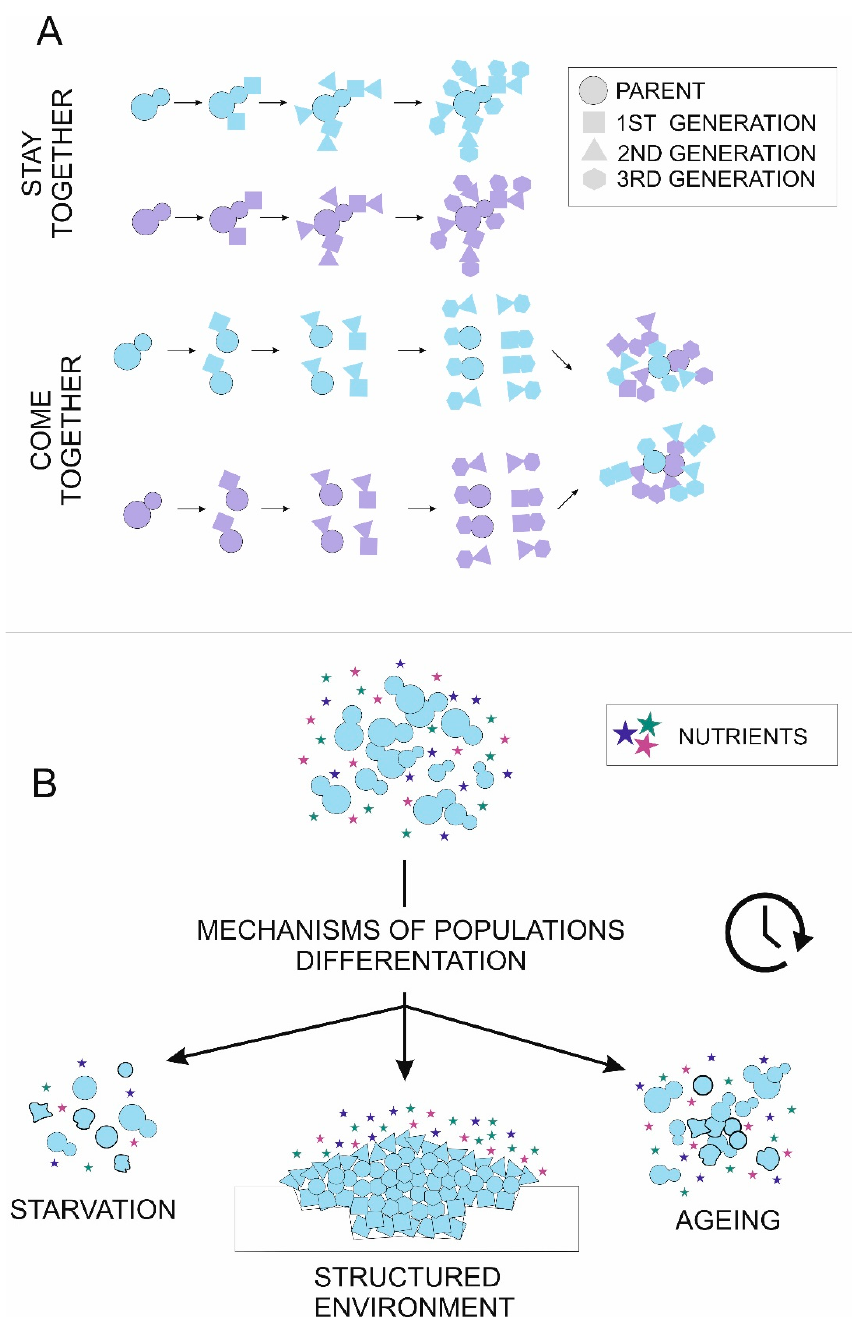
Figure 1. Mechanisms of cells aggregation ( A ) and cell differentiation ( B ) in multicellular yeast populations. ( A ) Colors symbolize cells ′ genetic background. Cell shape reflects successive divisions. Cell aggregates can form by the “stay together” strategy, where daughter cells stay attached to the mother cell, leading to the formation of clonal adhesions. Alternatively, cells separate after each division and can aggregate later by cell wall adhesins (“come together”), leading to the formation of groups with random relations between cells. Both stay together and come together strategies lead to the formation of two aggregates with 16 cells each, but relatedness between adjacent cells differs. ( B ) There are three major environmental signals causing cell heterogeneity — nutrient limitation (starvation), structured environment and population aging. Initially, identical cells in the population can enter the apoptosis pathway ( uneven shape ), enter the quiescence pathway ( bold outline ) or specialize to perform various tasks ( cell shape